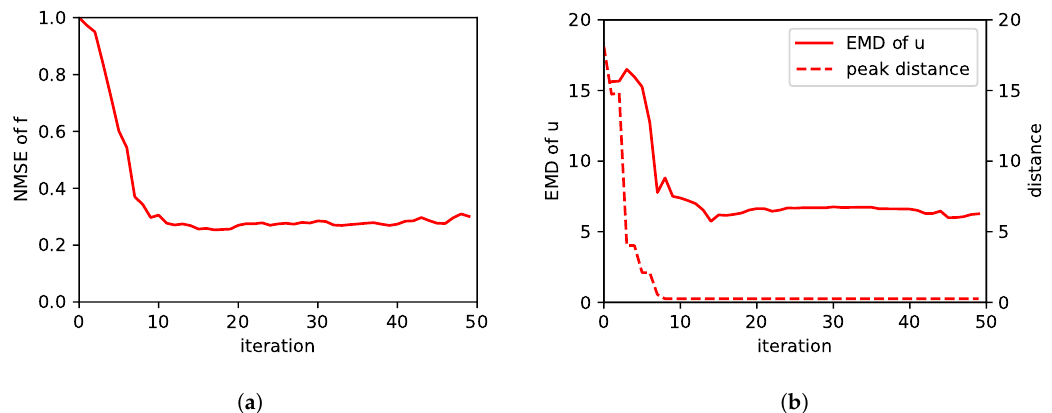
Figure 8. Performance of our exploration strategy in case of the mantaflow simulation: the plot in ( a ) shows the NMSE of the estimated concentration field. In ( b ) the EMD of the estimated source distribution is plotted. Besides, the Euclidean distance of the location of the simulated source and the peak in the estimated source distribution is shown.